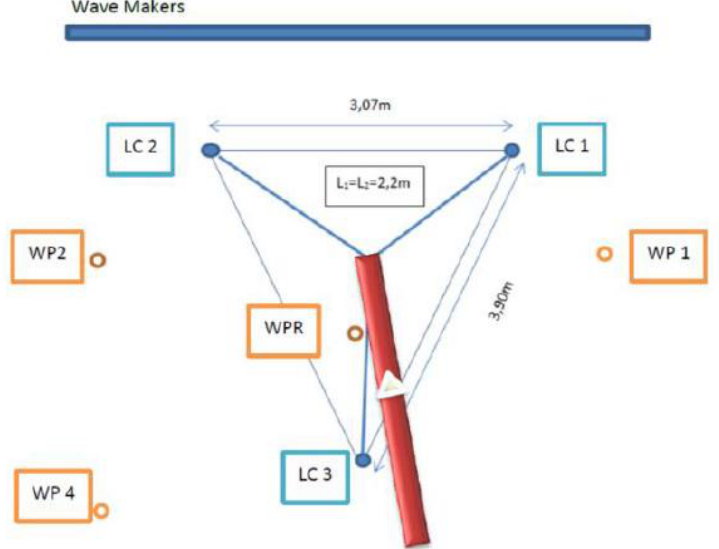
Figure 6. Experimental setup in the 12-meter-wide and 16-meter-long shallow water wave basin under QUBS in Portaferry.